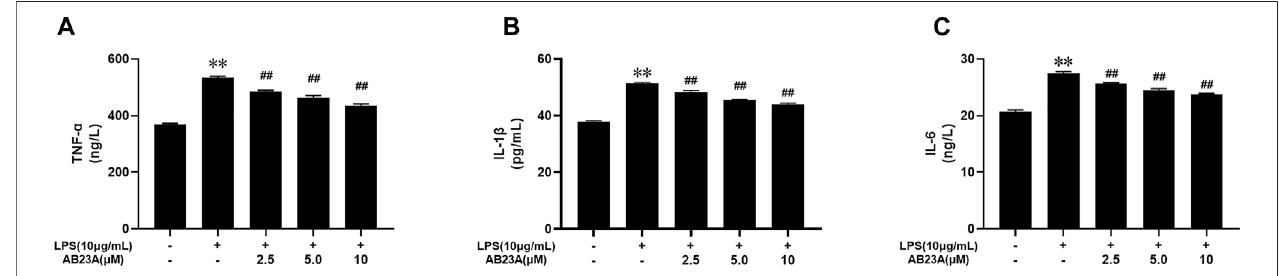
Frontiers in Pharmacology |